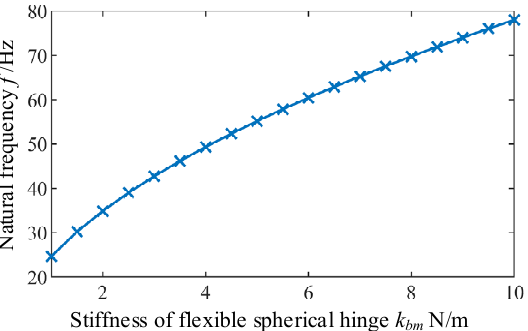
Figure 5. The influence the stiffness of flexible spherical hinge on the natural frequency of the micro-manipulator.